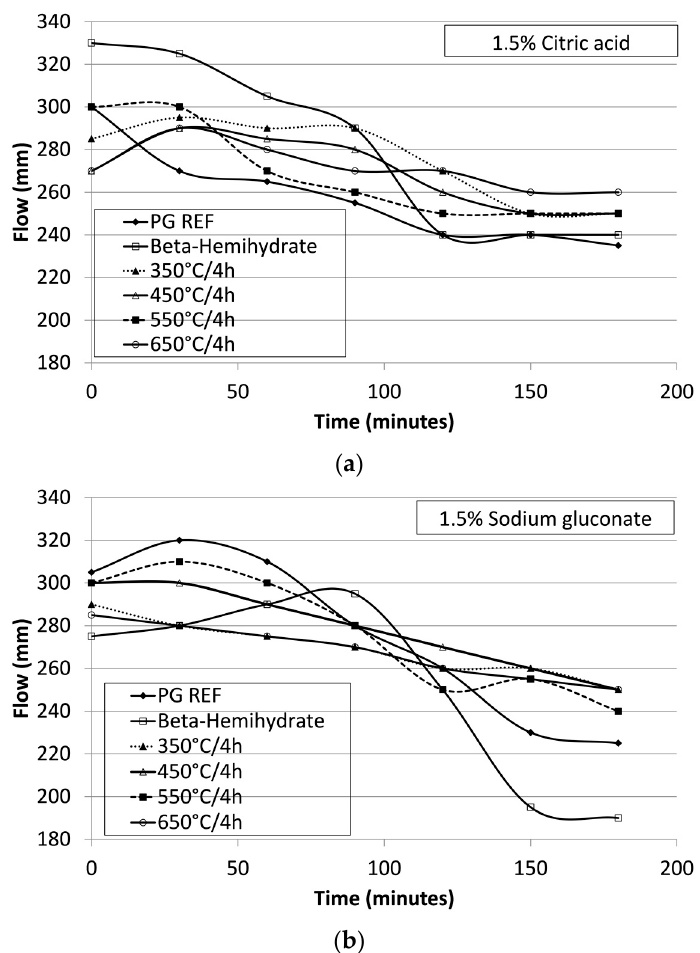
Figure 6. Maintenance of workability for 180 min with retardants citric acid ( a ) and sodium gluconate ( b ).